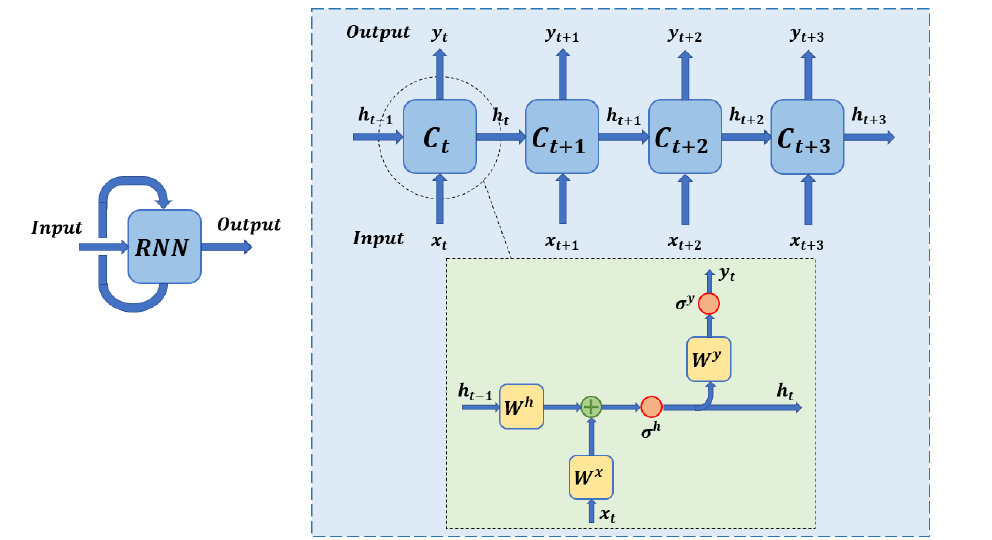
Figure 4. Generic schema of the content of a recurrent neural network